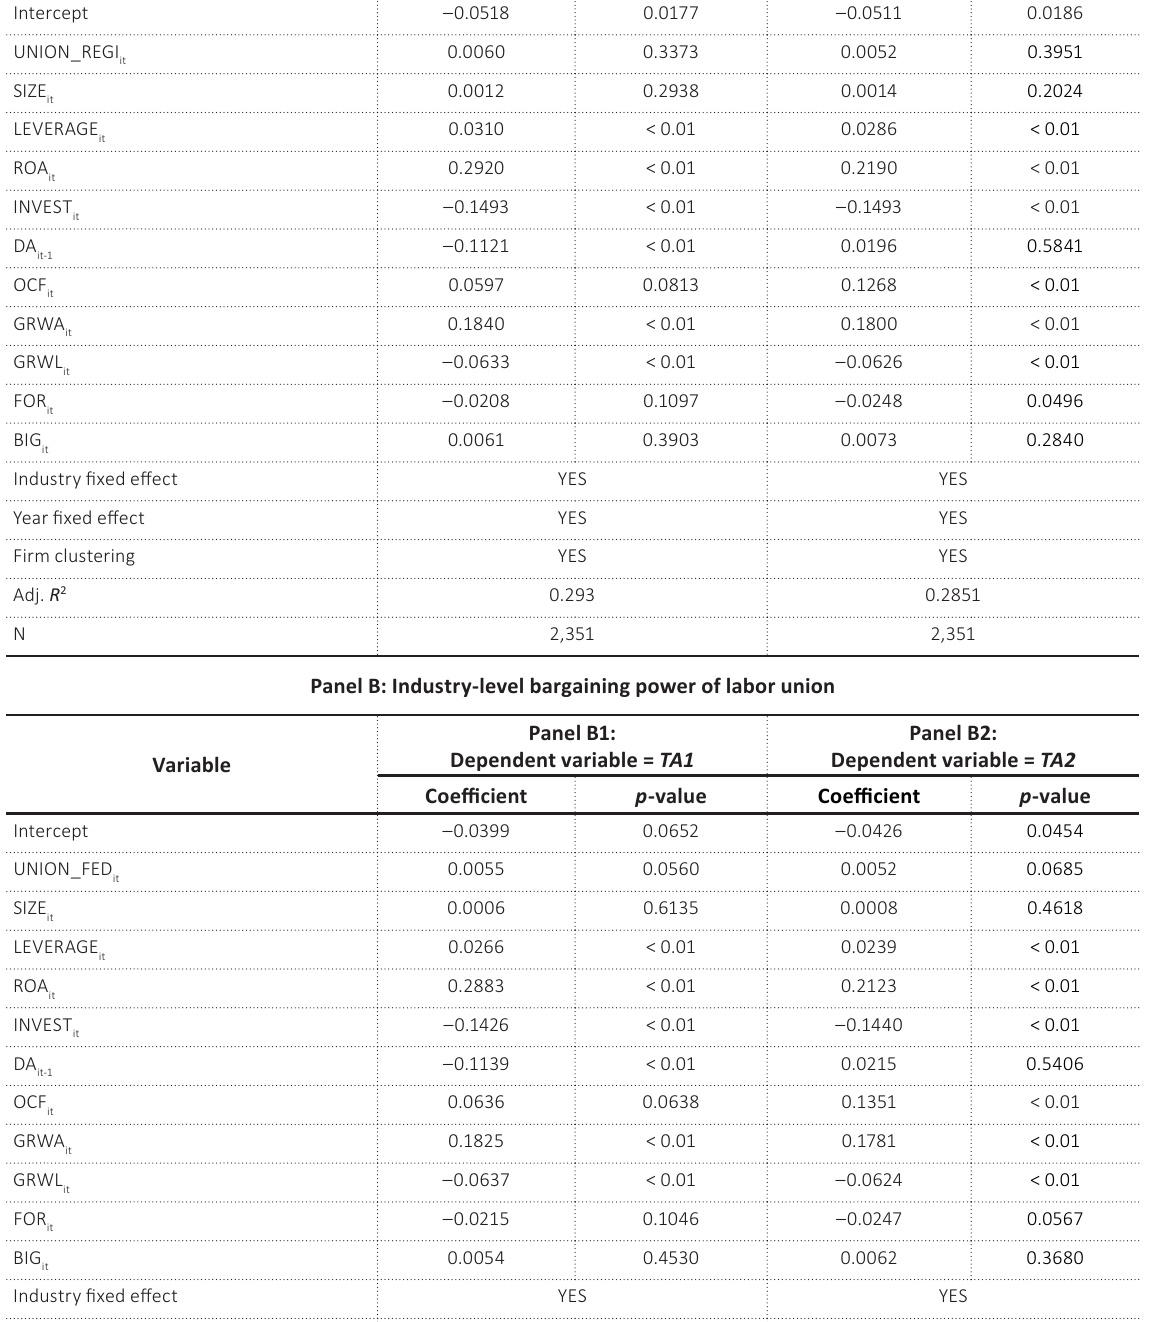
Table 3. The bargaining power of labor union and tax avoidance activities Panel A: Firm-level bargaining power of labor union Panel A1: Dependent variable = TA1 Variable